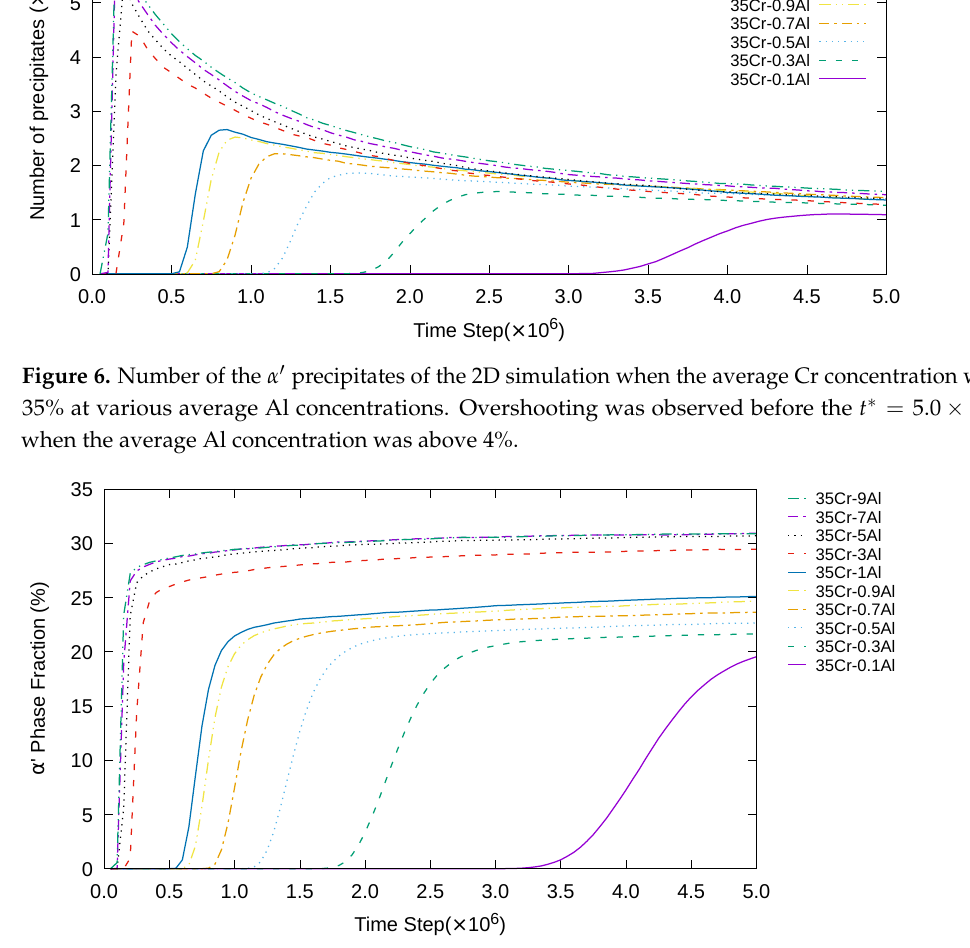
Figure 7. α (cid:48) phase fraction of the 2D simulation when the average Cr concentration was 35% at various average Al